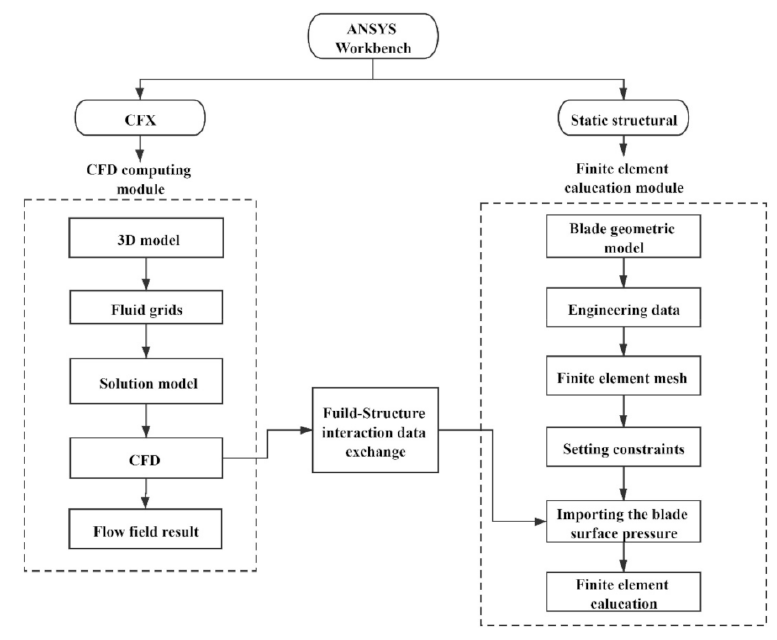
Figure 5. Flowchart of the FSI simulation.